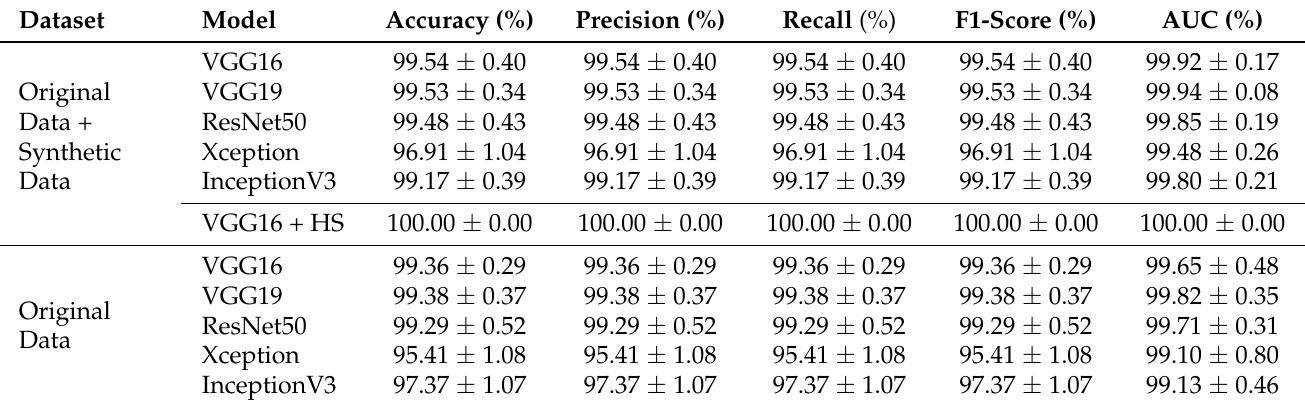
Figure 8. The loss curve for a single CNN model (VGG16) for 20 epochs. Table 2. A summary of the results obtained by the classifiers considered in this work. The results were reported after performing 20 iterations. Values in the table are in the format of mean ± std.